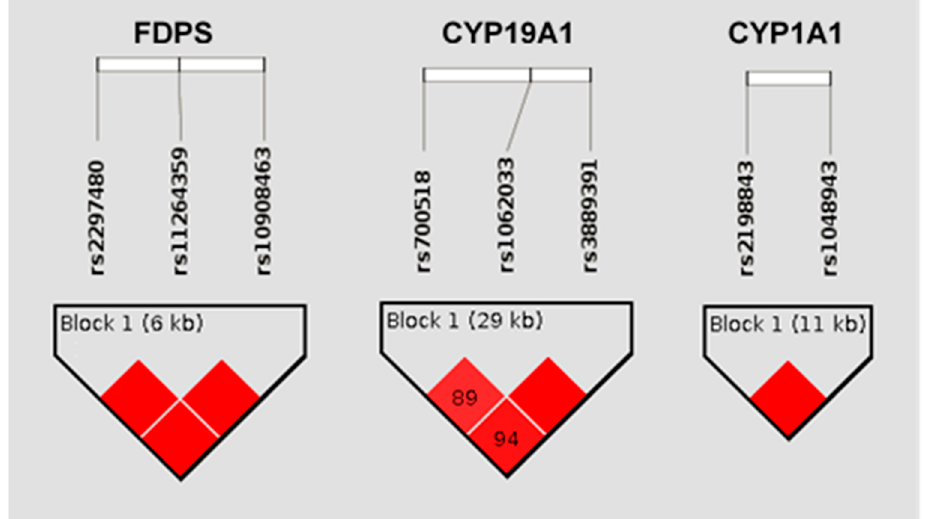
Figure 6. LD patterns of the most significant SNPs of the FDPS, CYP19A1, and CYP1A1 genes. The numbers in each square show between loci LD distances (D ′ ). When no number is shown, D’ = 100. In FDPS and CYP19A1 genes, other variants were included because they were in the same block and also slightly associated with BMD.